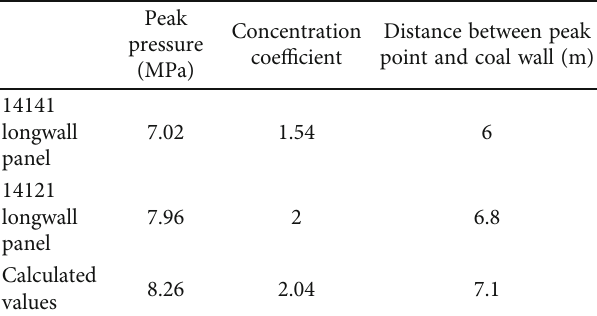
Table 5: Comparative analysis of 14141 and 14121 longwall panels and formula